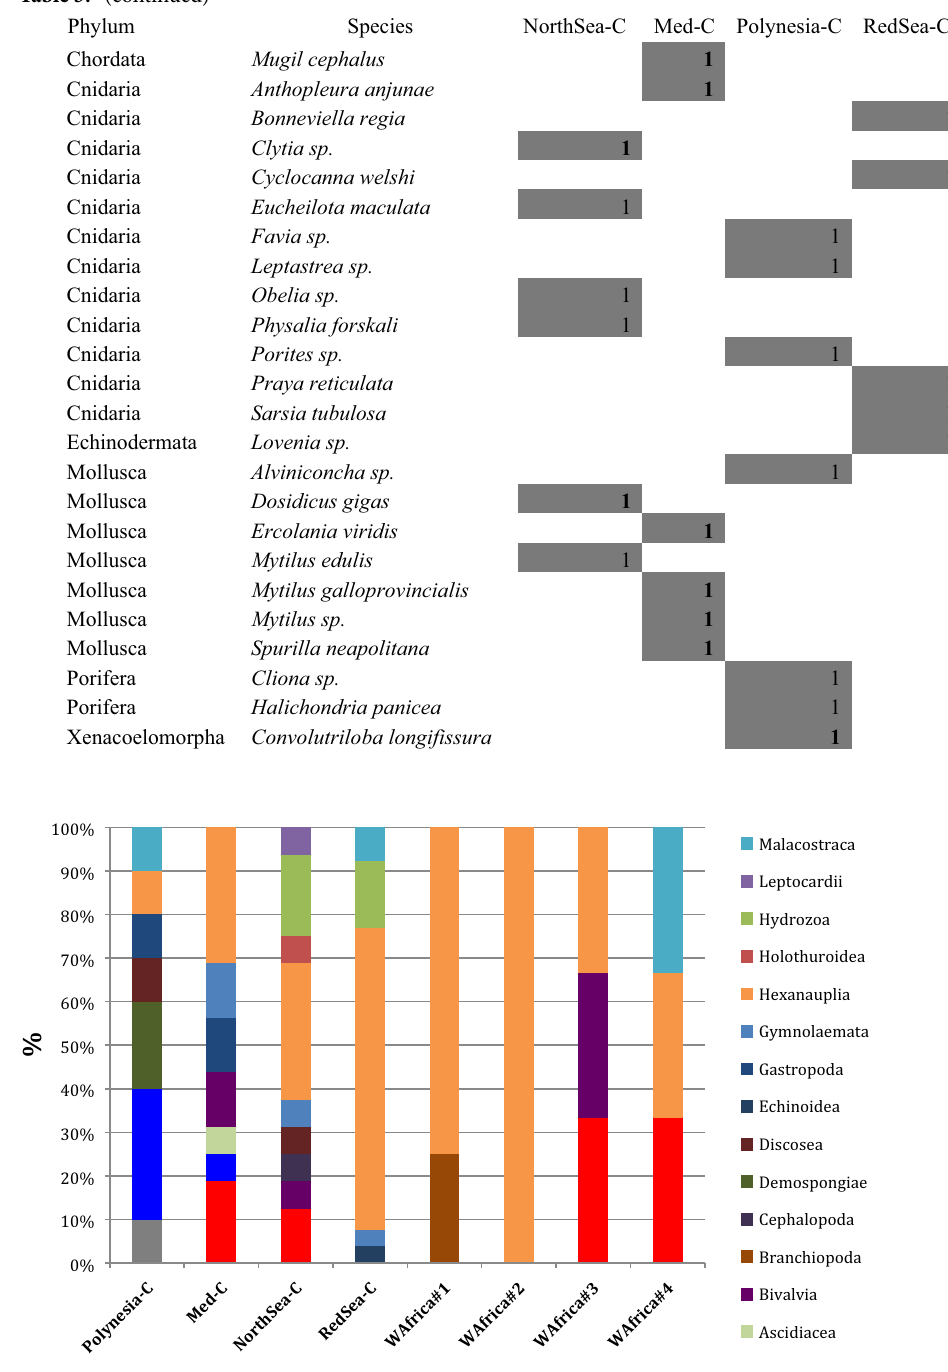
Figure 3. Taxonomic diversity of zooplankton in the analyzed samples, as proportion of species in different classes detected from